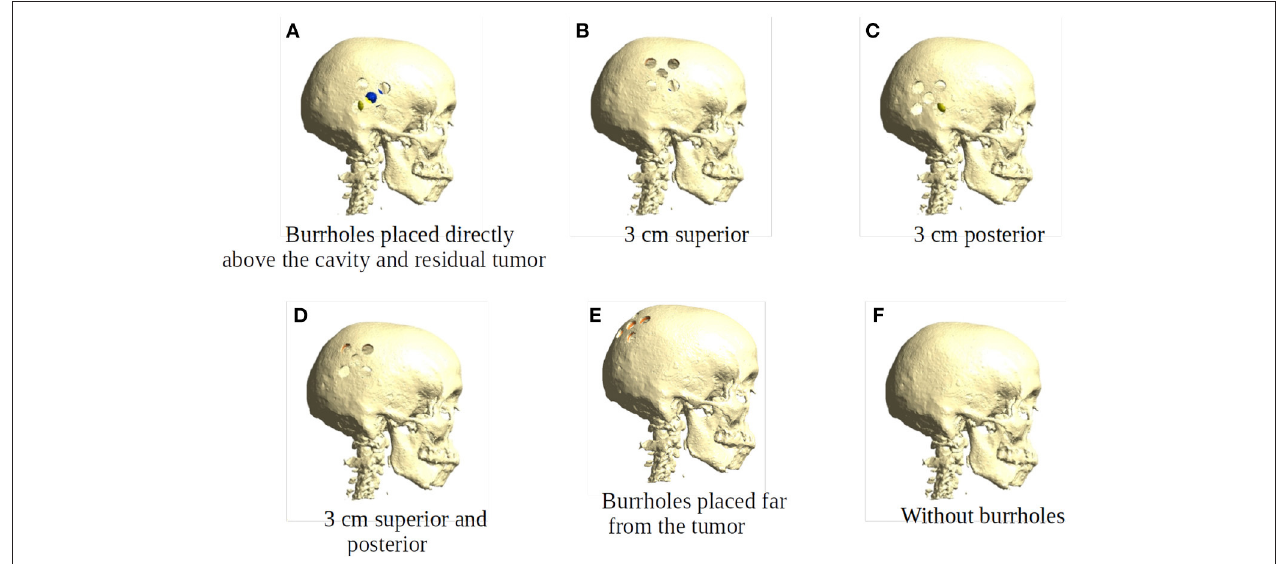
FIGURE 3 | Placement of burr holes. (A) shows the burr holes placed directly above the resection cavity and residual tumor. (B–E) show the burr holes placed 3cm superior, 3cm posterior, 3cm superior and posterior, and far from the resection cavity and residual tumor. (F) shows an intact skull that serves as the control in our